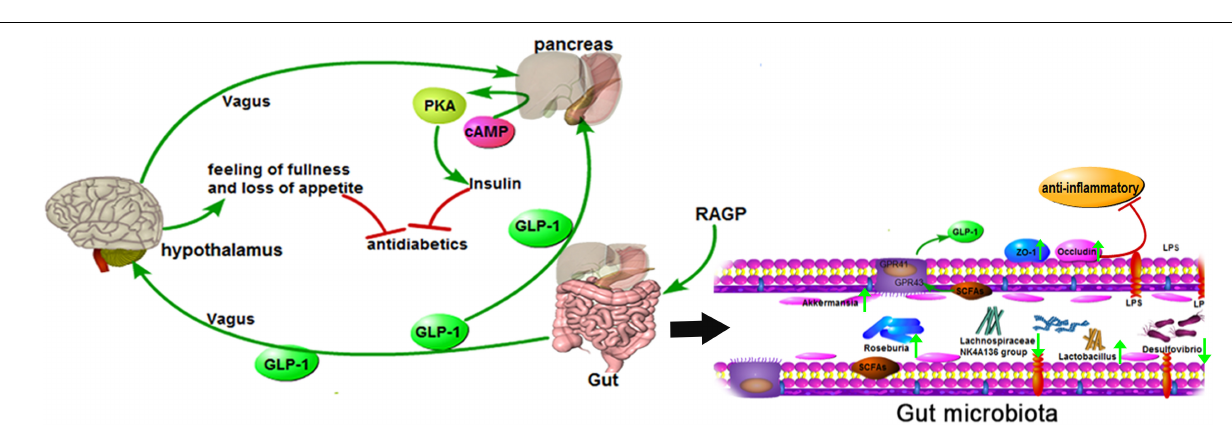
Frontiers in Microbiology |